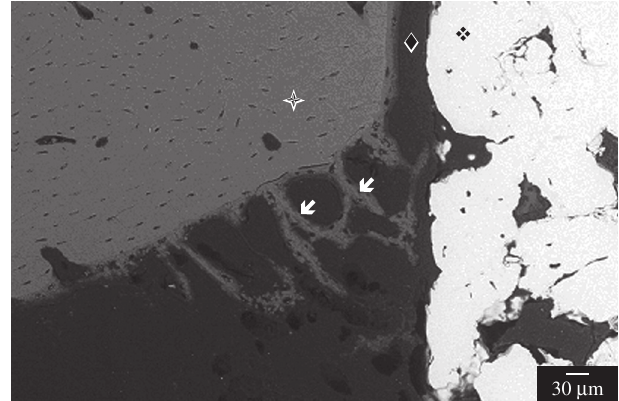
Figure 4. SEM photomicrograph of porous titanium scaffold one week after implantation in rabbit tibia: bone neoformation (  ), gap (  ) between bone (  ) and implant (  ).